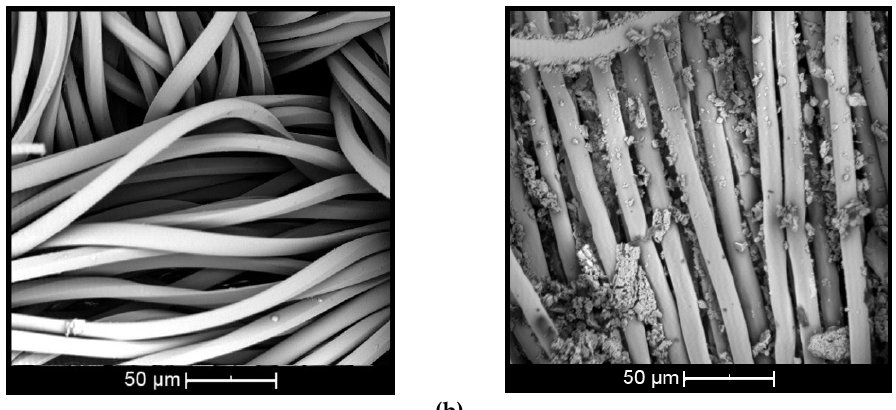
Figure 5. Scanning electron images of complex applied on: ( a ) cotton and ( b ) polyester (untreated textiles on left and treated on right).